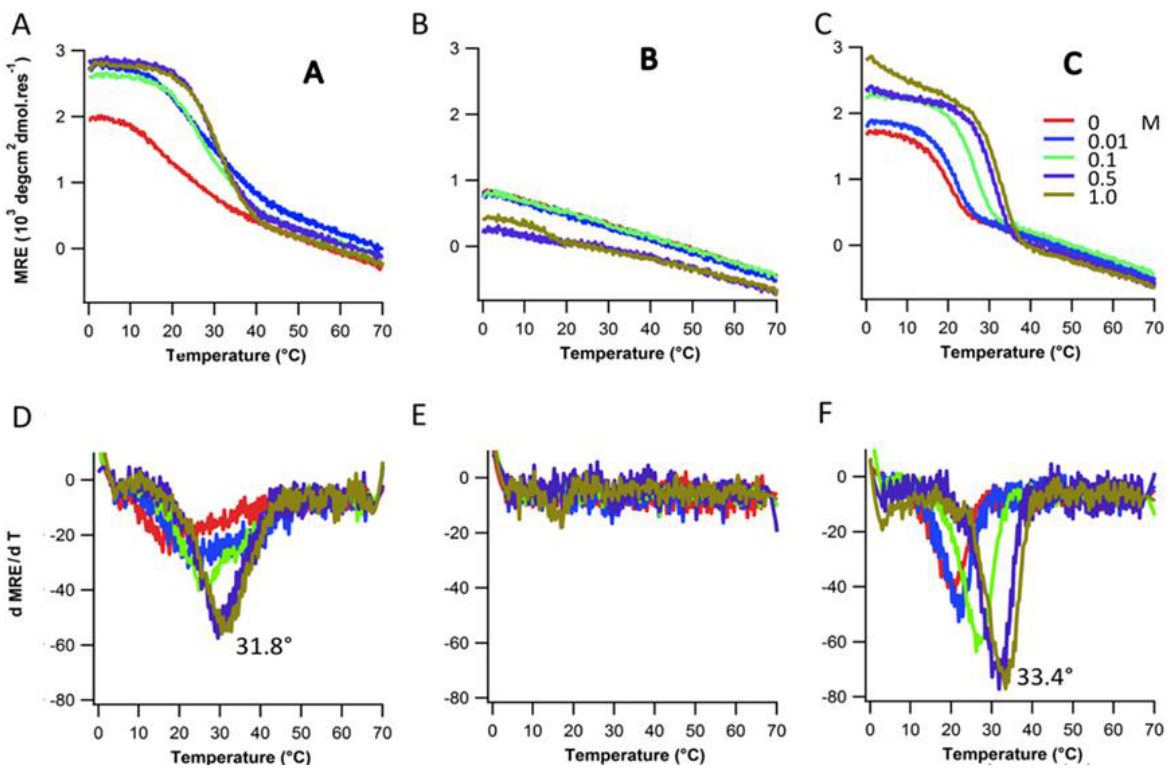
Figure 4. Thermal denaturation (top row) and their respective first derivative plots (bottom row) for A, B and C at various salt concentrations.